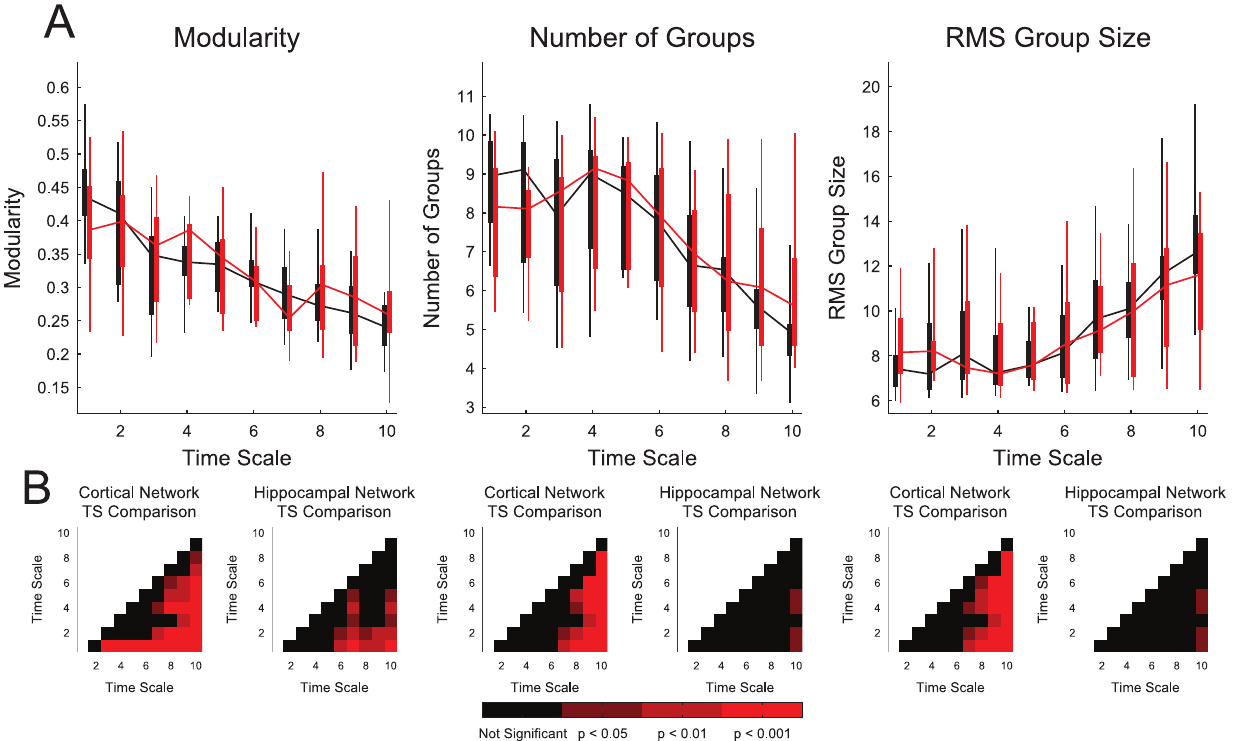
Fig. 7. Network modularity decreased with time scale. ( A ) Network modularity and the number of modules generally decreased with time scale, while the size of the modules generally increased with time scale. Box plots: minimum, 25 th percentile, median, 75 th percentile, maximum data set (recording). No significant differences between hippocampal and cortical networks were observed. ( B ) Multiple comparisons corrected Mann-Whitney Test p-values across different time scales for identical tissue types. Note that the changes with time scale in (A) were generally significant, especially for cortical